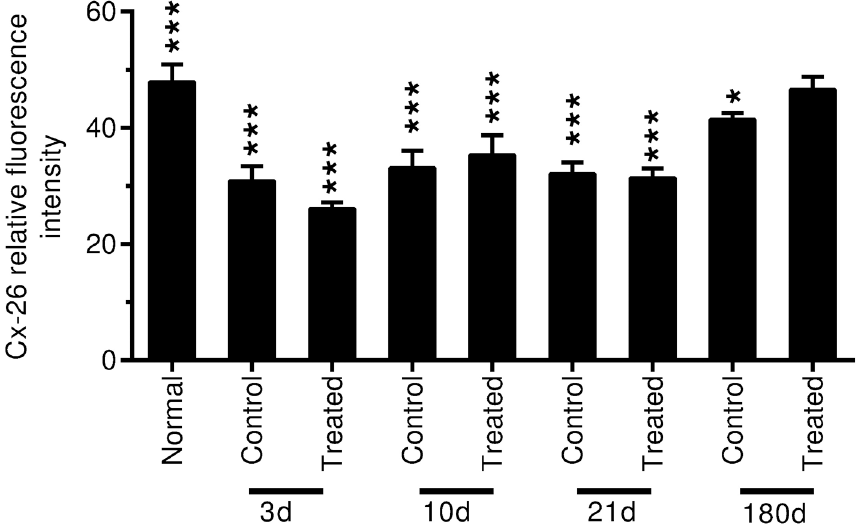
Fig 15. Connexin 26 relative fluorescence intensity in the spiral ligament in the middle and basal turns is measuredand statistically analyzed. Significantlydecreased expressionof Cx-26 is observedin the spiralligament of control and treated animalsin the noise exposuregroups from specimenscollected at 3 to 21 days after noise exposure( *** p < 0.001). Significant decreased Cx-26 expression is also observedin the control group 6 months after noise exposure( p < 0.05). No significantchangeis observedin Cx-26 expressionin the spiralligament of the treated group 6 months after noise exposurecomparedto the normal (na ï ve)animals ( p > 0.05). No significantdifference is observedbetweencontrol and treated groupsat each point after noise exposure( p >